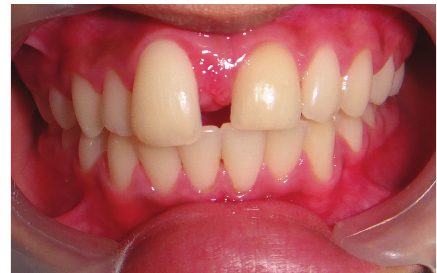
Figure 1: Spacing between 11 and 21 with extrusion and slight labial displacement of 11.